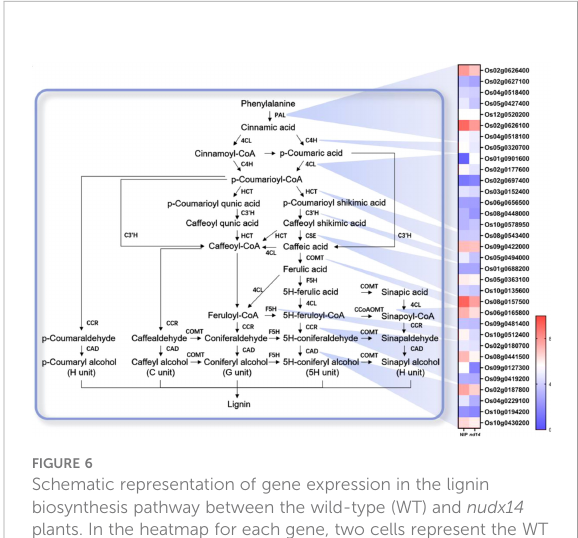
relative expression levels were performed to be downregulated in both nudx14 lines by RT-qPCR (Figure S5). Overall, the